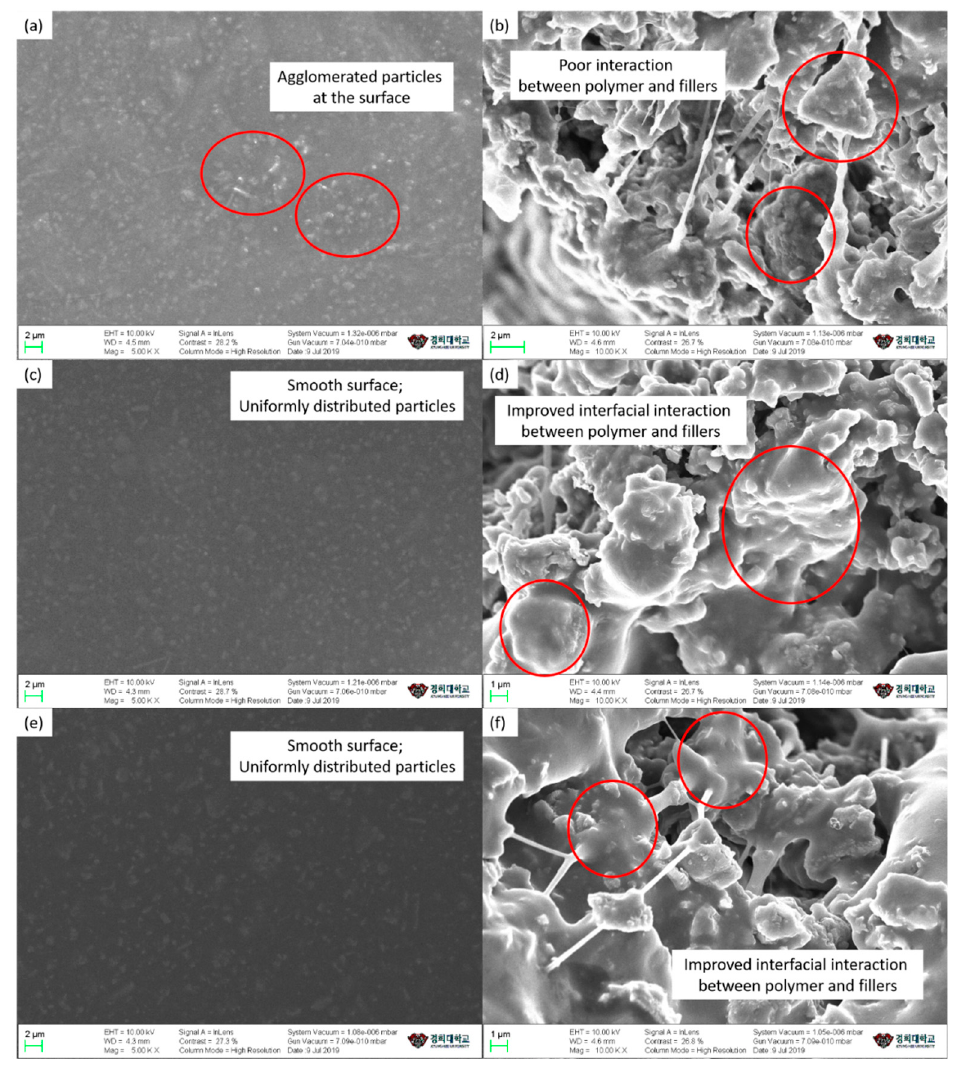
Figure 4. FE-SEM images of ( a , b ) µ-AlN/n-AlN/PSA, ( c , d ) Si-µ-AlN/n-AlN/PSA, and ( e , f ) Si-µ-AlN/PSA, respectively, where ( a , c , and e ) are showing surface morphology, while ( b , d , and f ) are the cutting edge of samples.